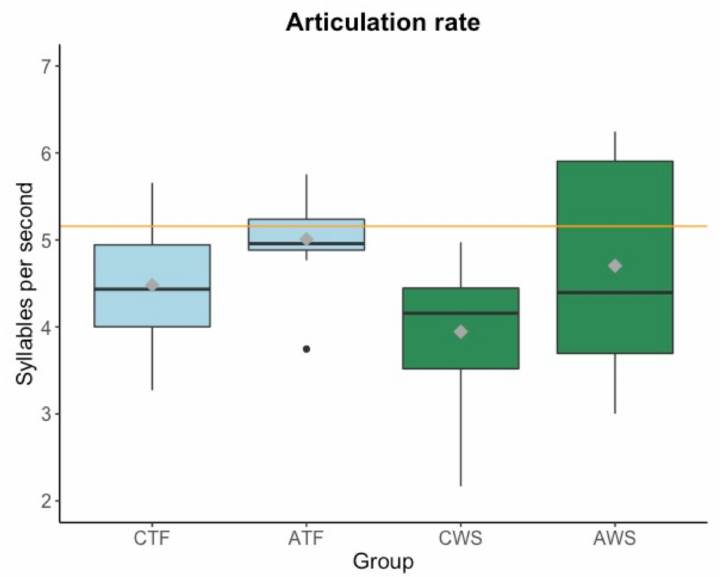
Figure 3. Boxplots of articulation rate in syllables per second (without disfluencies, disfluent pauses, and pauses > 250 ms) (y-axis). Mean values per group are visualized with a gray diamond within each boxplot. Articulation rate of a professional audiobook reader is displayed as a reference with an orange horizontal line. CTF: children with typically fluent speech, ATF: adolescents with typically fluent speech, CWS: children who stutter, AWS: adolescents who